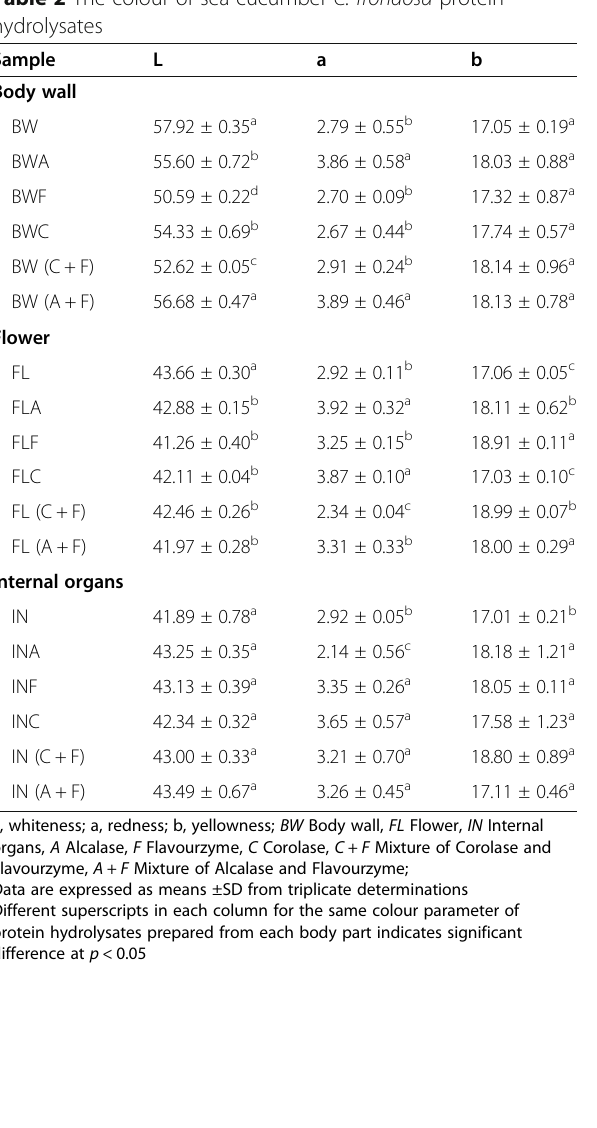
Table 2 The colour of sea cucumber C. frondosa protein hydrolysates